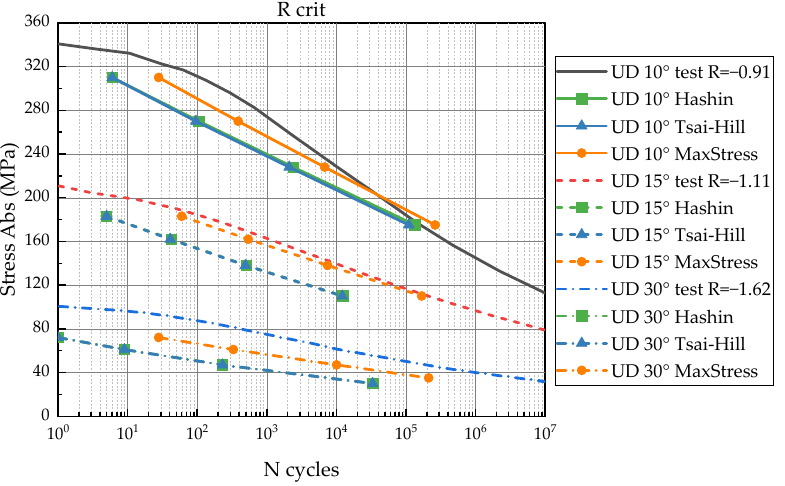
Figure 10. Comparison between experimental and predicted S-N curves of UD 10, 15, 30° for R = 10. Figure 11 illustrates a comparison between S-N curves in combined tension-compres- sion mode, R crit = −0.91, −1.11 and −1.62 for 10°,15°, and 30°, respectively. Hashin and Tsai– Hill criteria provided conservative results and were less accurate than for the maximum stress criterion. However, this criterion indicated a tendency to overdue fatigue stress at cycles above 10 5 for UD 10° and 15°, due to a significant variability in the degradation rate of the experimental S-N curve.